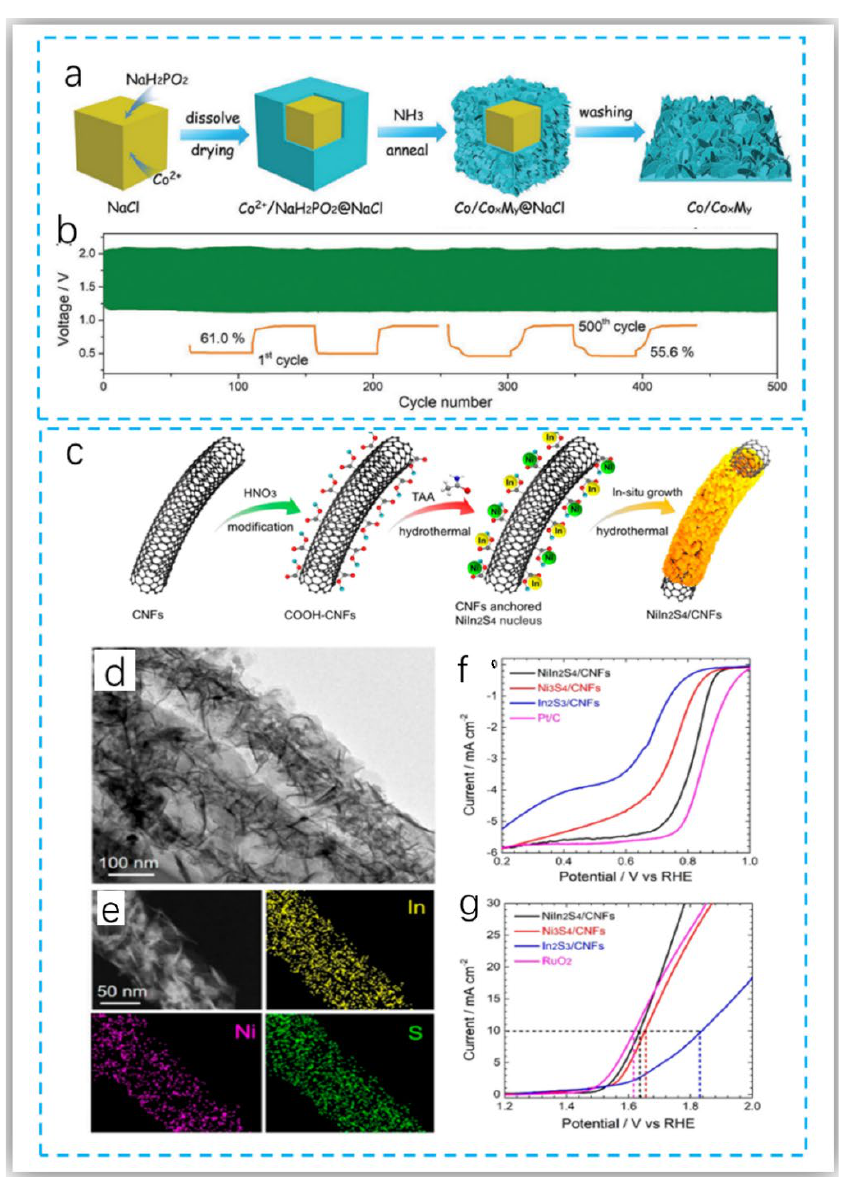
Figure 13. ( a ) Schematic of the process for the synthesis of Co/Co x M y catalyst, ( b ) Galvanostatic cycling stability of Co/Co x M y +Pt/C based battery (10 mA cm − 2 ) [65], reprinted with permission from Ref. [65]. Copyright © 2019 Wiley-VCH Verlag GmbH & Co. KGaA, Weinheim. ( c ) Schematic illustration of the formation of NiIn 2 S 4 /CNFs [107], ( d ) TEM images of NiIn 2 S 4 /CNFs, ( e ) EDS-mapping of NiIn 2 S 4 /CNFs, ( f ) ORR polarization curves of series NiIn 2 S 4 /CNFs, ( g ) OER polarization curves of series NiIn 2 S 4 /CNFs. Reprinted with permission from Ref. [107]. Copyright © 2019 American Chemical Society.